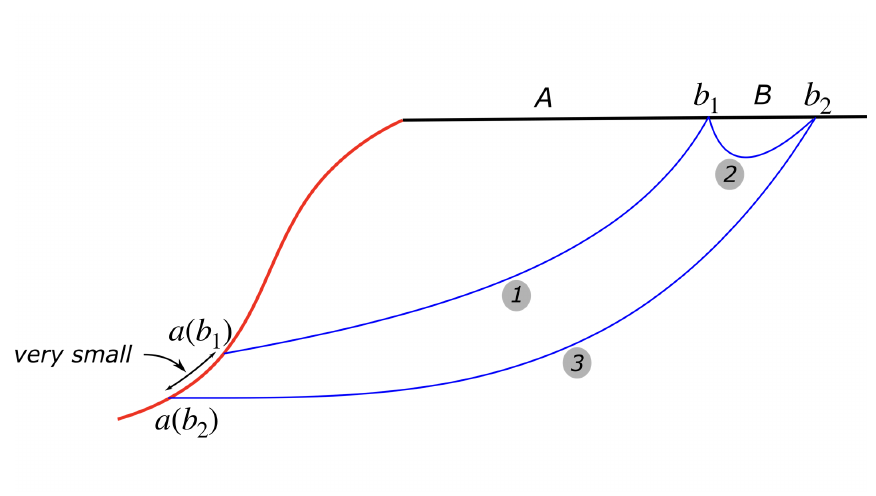
Figure 14: Schematic of the island proposal-I for the entanglement negativity of the mixed state of the adjacent intervals in